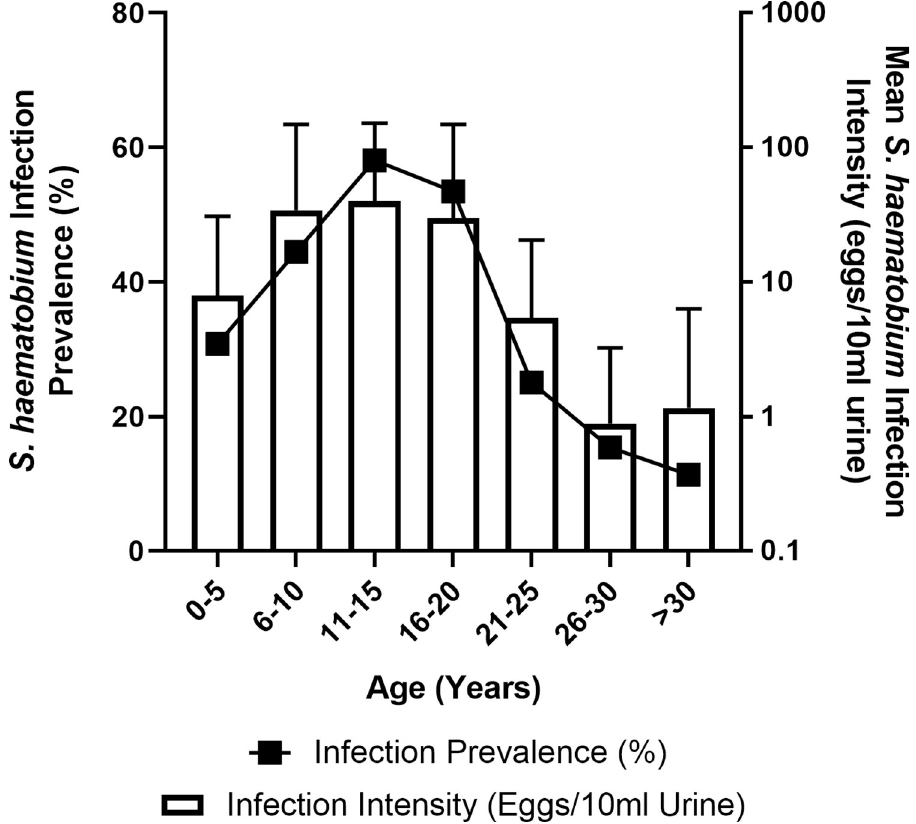
Fig 1. S. haematobium epidemiology across age groups. The epidemiological data indicated that children aged 11 to 15-years-old experienced both the highest S. haematobium prevalence (%) and intensity (eggs/10ml urine), and that the lowest levels were experienced by individuals 26-years-old and older. Error bars indicate